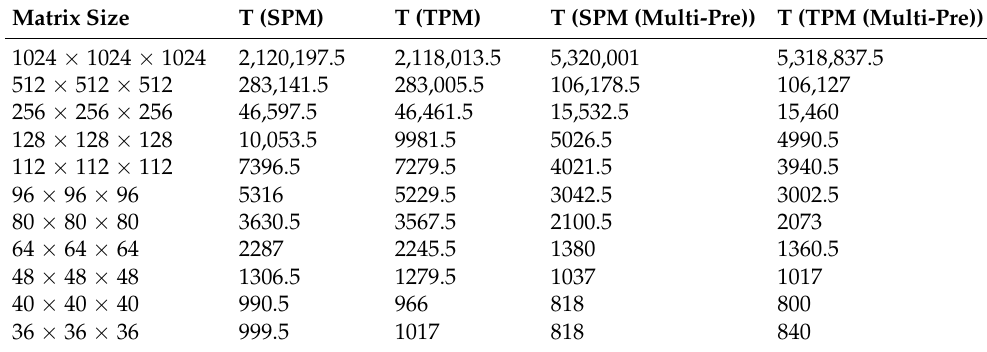
Table 3. Computational Efficiency